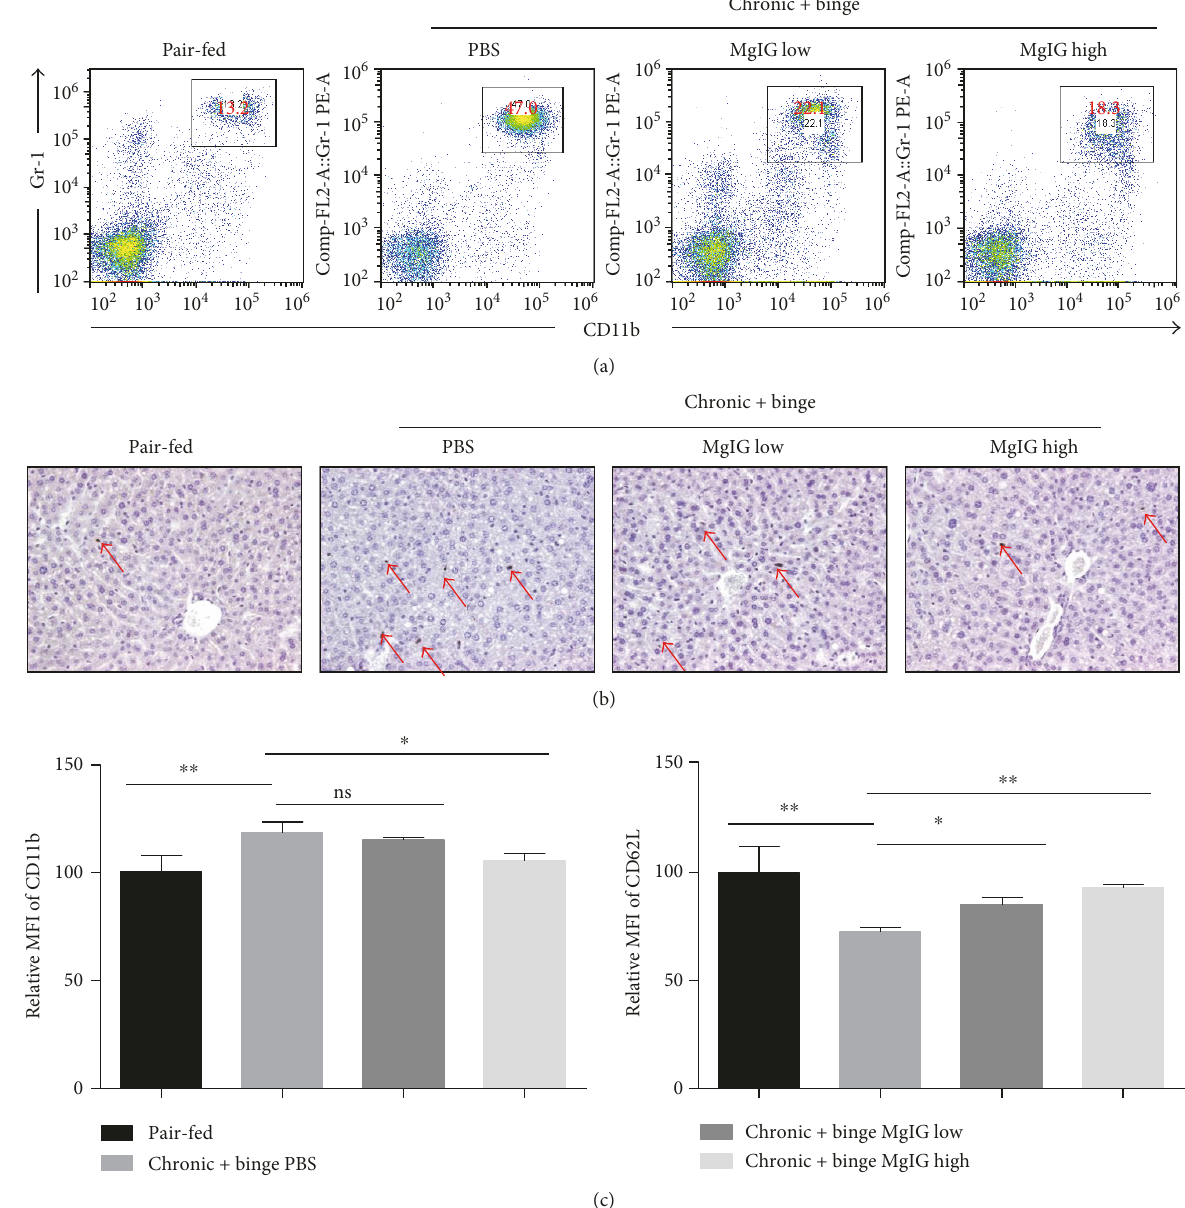
Figure 2: MgIG prevents chronic plus binge ethanol feeding-induced neutrophil in fi ltration in the liver. Mice were treated as described in Figure 1. (a) Liver leucocytes were isolated and analyzed by fl ow cytometry. The percentage of neutrophils (Gr1 +CD11b+) in liver leucocytes was determined. (b) Immunohistochemical staining of MPO-positive neutrophils in the liver. (c) Relative mean fl uorescence intensity (MFI) of the cell surface levels of CD11b and CD62L on liver neutrophils determined by fl ow cytometry. Increase of CD11b and decrease of CD62L are associated with the activation of neutrophils. Values represent means ± SEM. ∗ p < 0 05 , ∗∗ p < 0 01